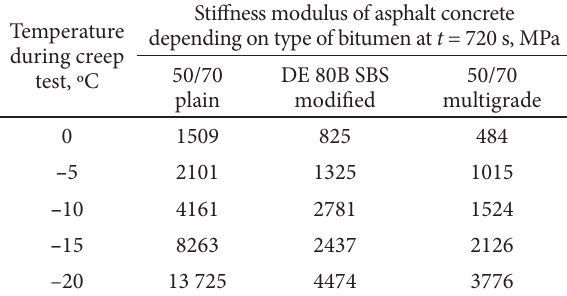
Table 2. The values of stiffness modulus of asphalt concrete for different testing temperatures and constant loading time t = 720 s Temperature during creep test,